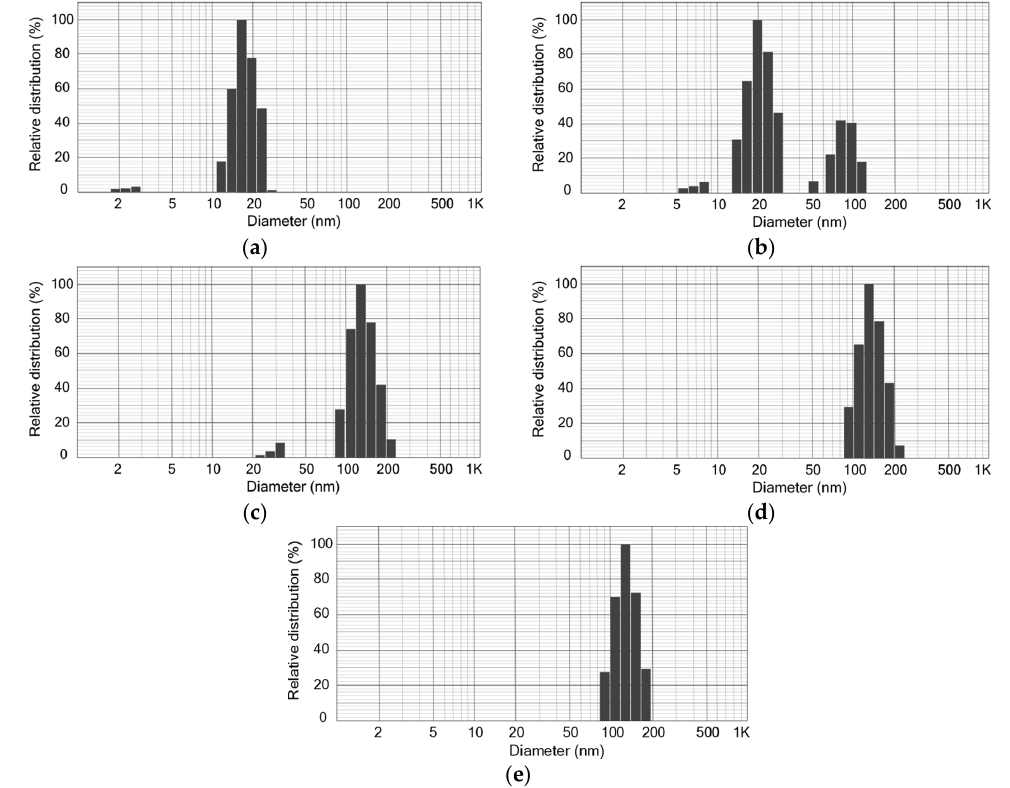
Figure 4. Particle size distribution of the permeate from dead-end filtration tests involving ( a ) 28 nm SiO 2 NPs; ( b ) 28 nm SiO 2 NPs + activated sludge; ( c ) 144 nm SiO 2 NPs; ( d ) 144 nm SiO 2 NPs + activated sludge and ( e ) activated sludge only.